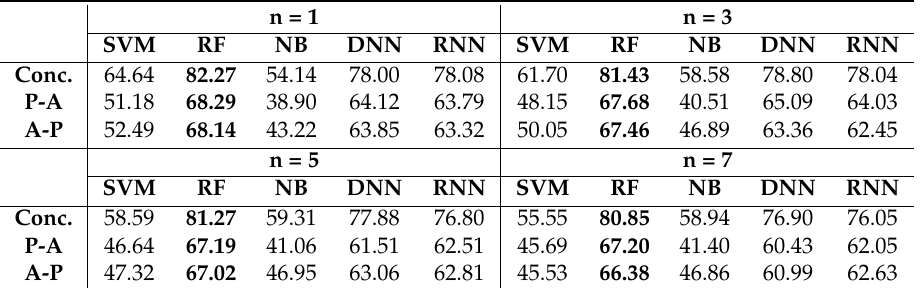
Table 10. Accuracies of concurrent, possession-action, and action-possession recognition for different number of windows.